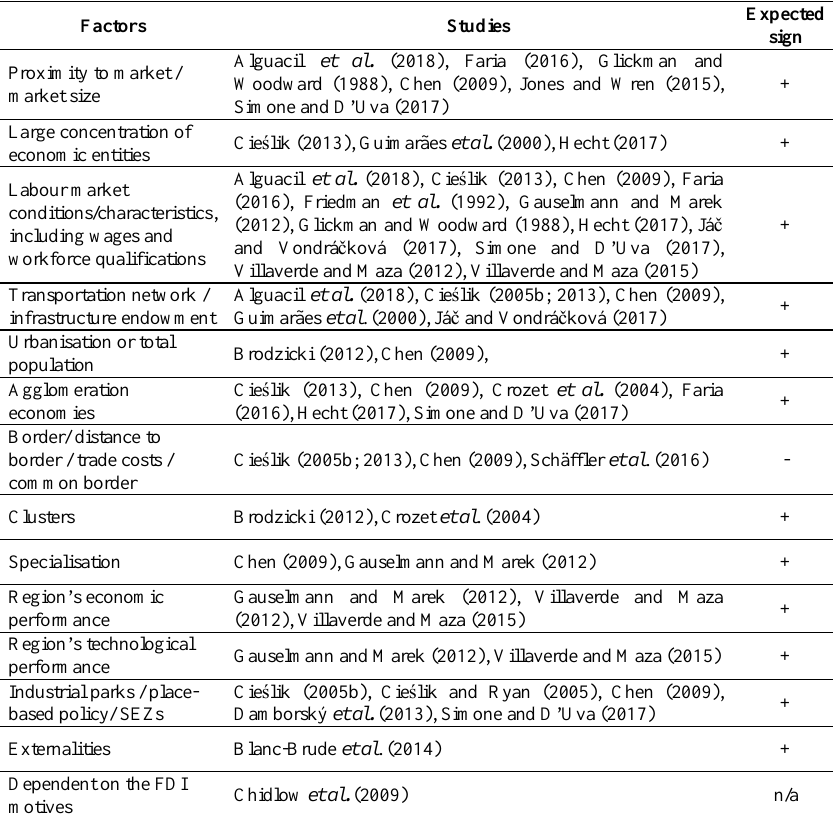
Table 1. FDI locational factors in regional